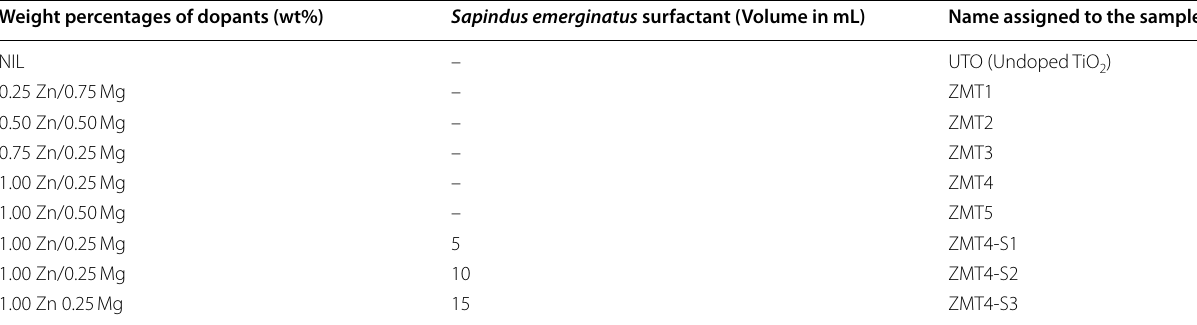
Table 1 Details of all the samples synthesized Weight percentages of dopants (wt%) Sapindus emerginatus surfactant (Volume in